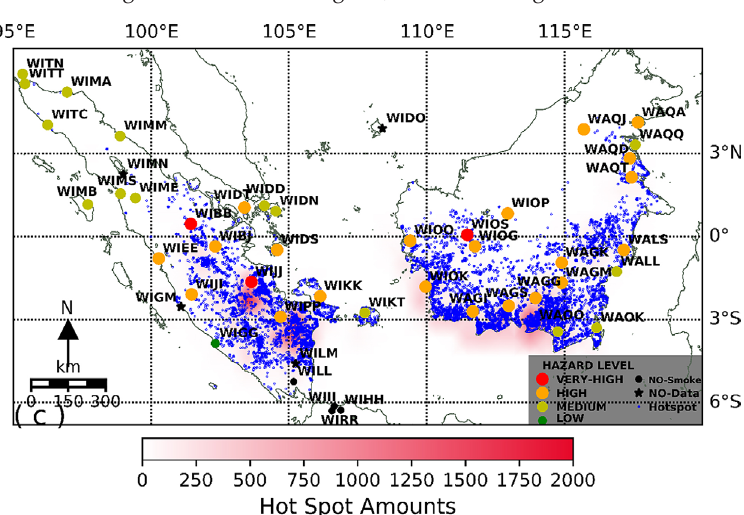
Fig. 4 c. The same as Fig. 4 a, for month September